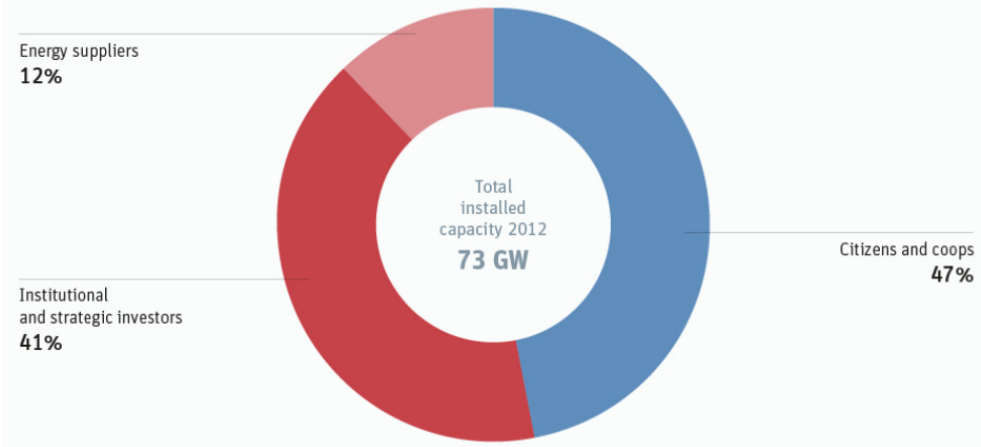
Figure 5. Installed capacity of renewable energies in Germany in 2012 as per property owner [29] * (* Coops stands for ‘energy cooperatives’: community-owned renewables